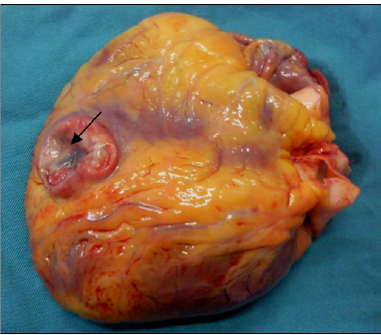
Figure 1. Cyst found in the right ventricle of the heart.